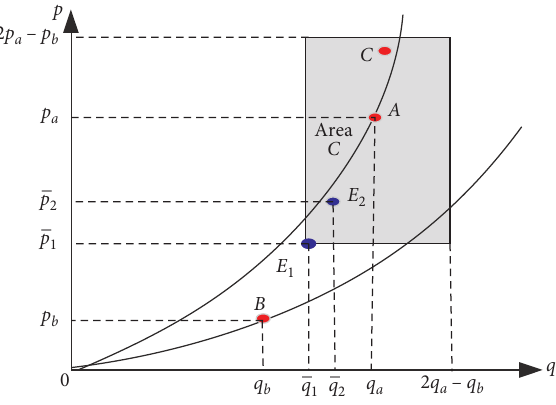
Figure 3: Interval of decoy product c